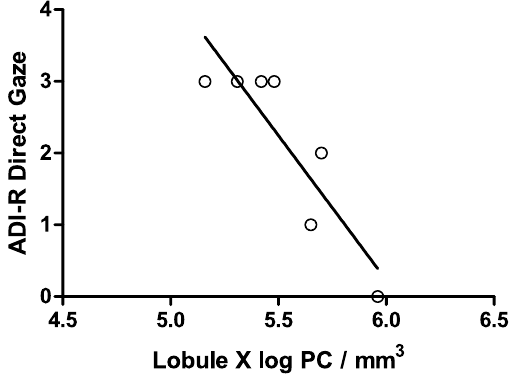
Figure 5. Lobule X PC Density is Associated with Direct Gaze. Lobule X PC density in the autism group negatively correlated with ADI- R question 50, which assessed the social and communicative use of eye contact (R 2 = 2 0.75 6 0.04, p=0.012). Higher scores on the ADI-R correspond with increased symptom severity. One case from the autism group was lacking sufficient ADI-R data to be included in this analysis.